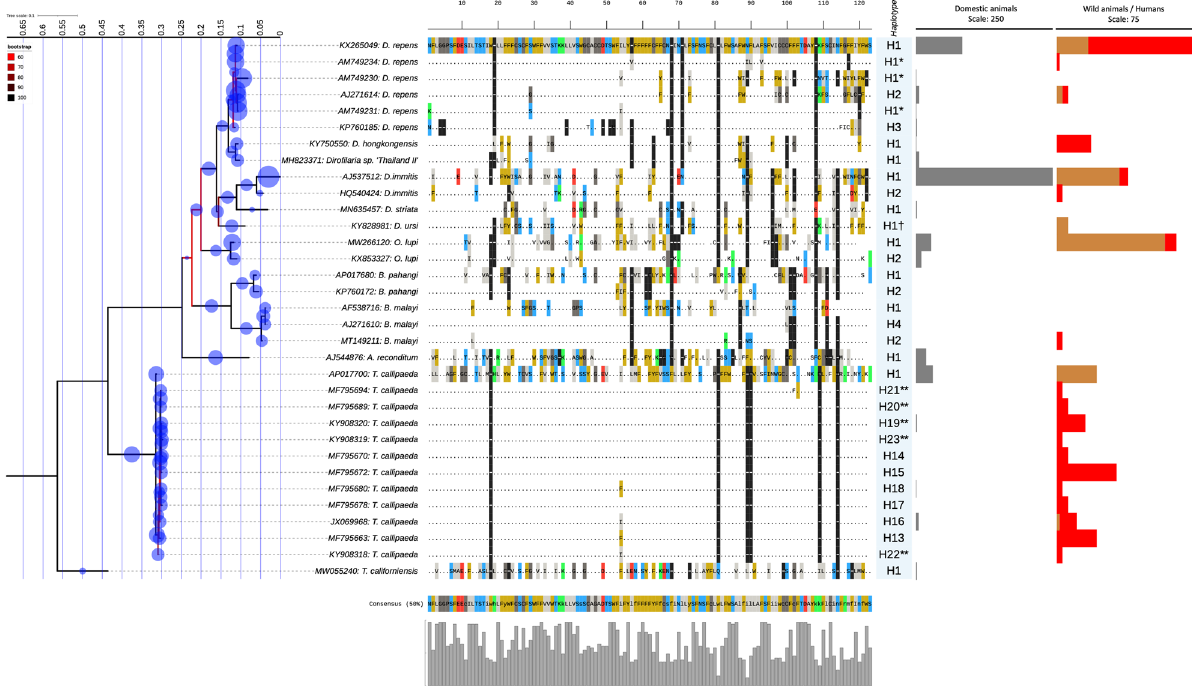
Figure 3. ML phylogeny showing the distribution of the haplotypes of zoonotic VBHs of canids delineated by the cox1 and 12S rRNA distance clustering. The tree corresponds to the IQTREE inferred from 33 concatenated (1064 bp) DNA sequences with 29.13% of informative sites using the (+F+R5) model under 1000 bootstrap replicates and ML method. Branch are color-coded according to the bootstrap value. Species name and GenBank accession number are indicated at the tip of each branch. The tree includes 704 (478 cox 1 and 226 12S rRNA) partial query sequences from the zoonotic VBHs of canids (blue circle) placed at the branch and leaf nodes by the EPA-ng algorithm. The MY_SCHEME_1sequence alignment viewer of the concatenated informative sites from the cox1 and 12S amino acid alignment and their 50% consensus are shown. The amino acid sequences of the haplotype 1 from each species were used as reference sequence to dot repeats in amino acids throughout the whole haplotypes of the species. Haplotype names are indicated for each node label. Number of domestic, wild, and human infection cases with each haplotype are shown by the bar charts at each node. * and ** indicate delineation failure of the cox 1 and 12S rRNA distance clustering respectively. † Indicates inconsistency between the morphological taxonomy and the present molecular